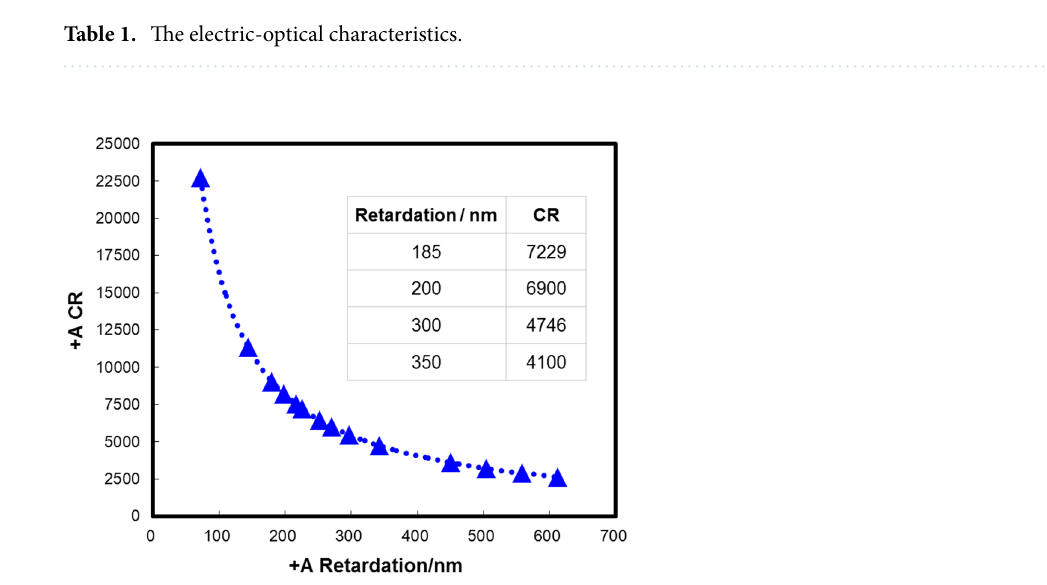
Figure 8. The CR of +A at different